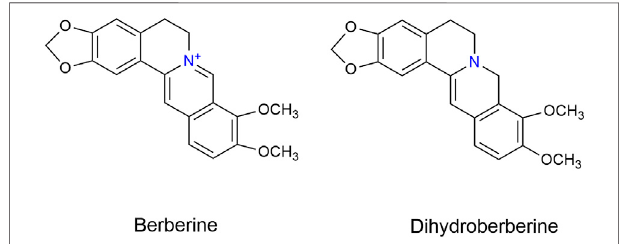
FIGURE 1 | Chemical structures of BBR and